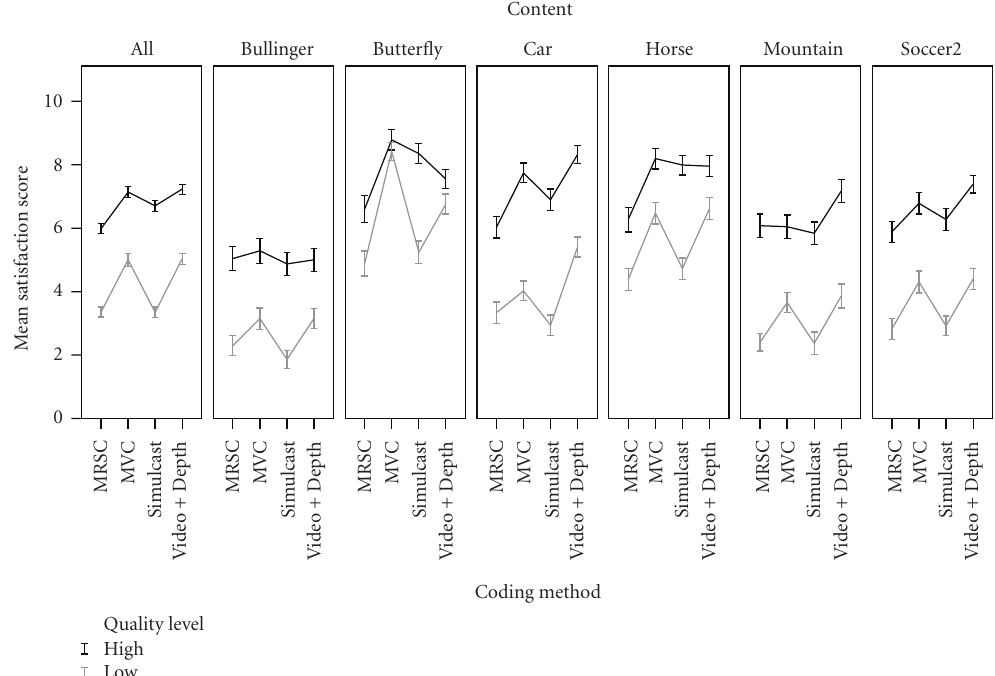
Figure 13: Mean satisfaction scores for the coding methods given at high and low quality levels. Error bars show 95% CI of